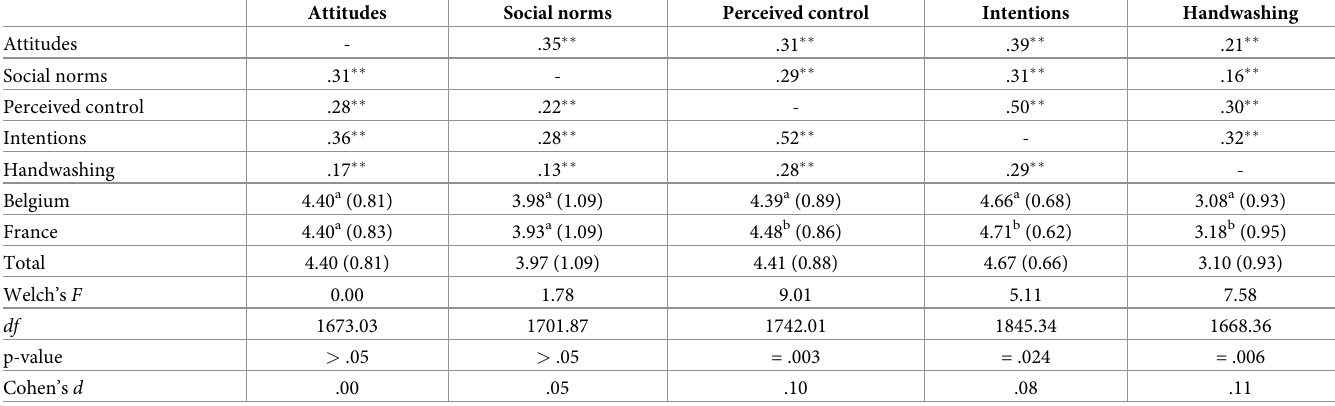
Table 2. Correlation matrix with Belgian above and French below, means and standard deviations for